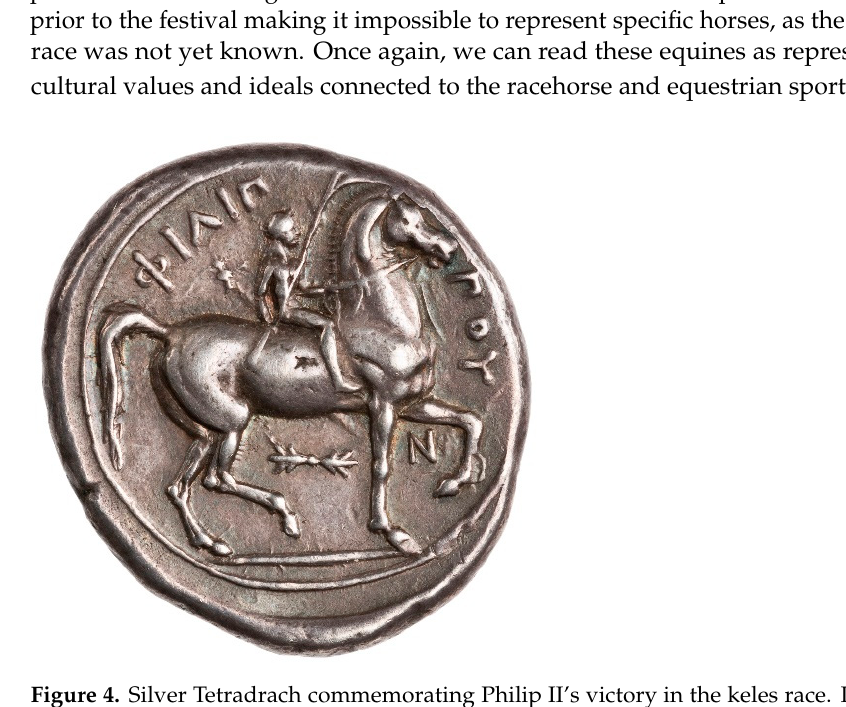
Figure 4. Silver Tetradrach commemorating Philip II’s victory in the keles race. Issued c. 348-329 BCE. American Numismatics Society. Inv. no. 1967.152.195.